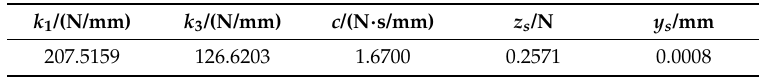
Table 2. Identification result (vibration amplitude = 0.172 mm, frequency = 5 Hz).